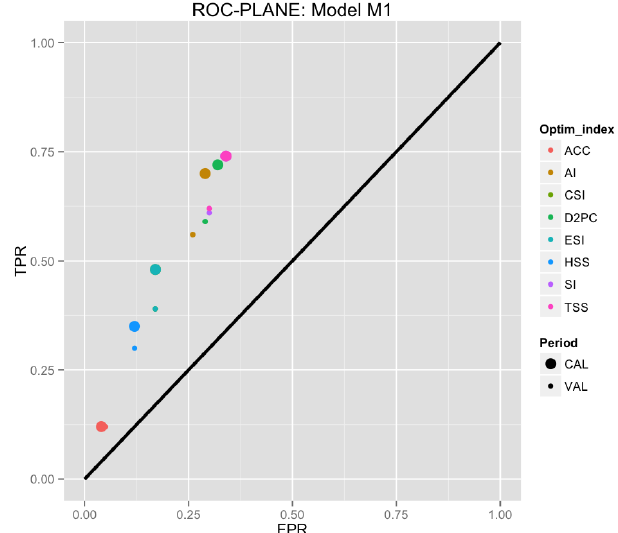
Figure B1. Models’ performance results in the ROC plane for M1.